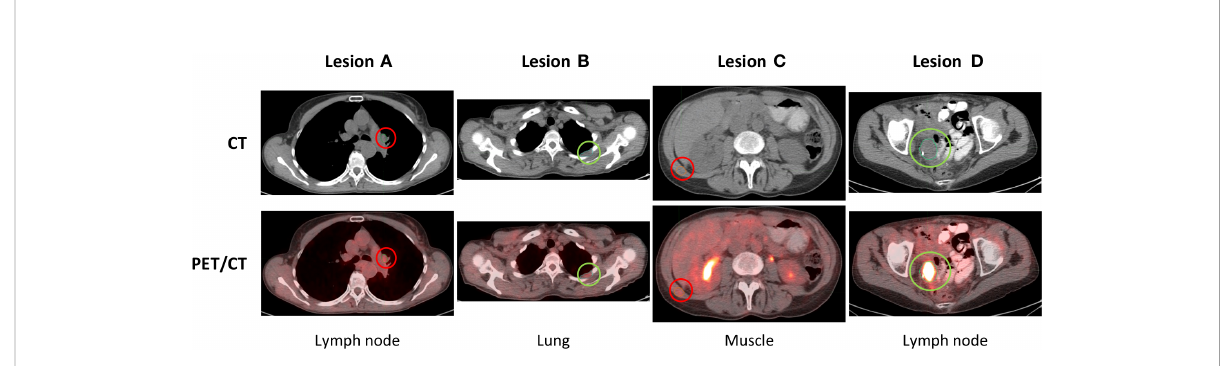
FIGURE 1 Baseline images of hyperprogressing (A, C) and non-hyperprogressing (B, D) lesions of a selected